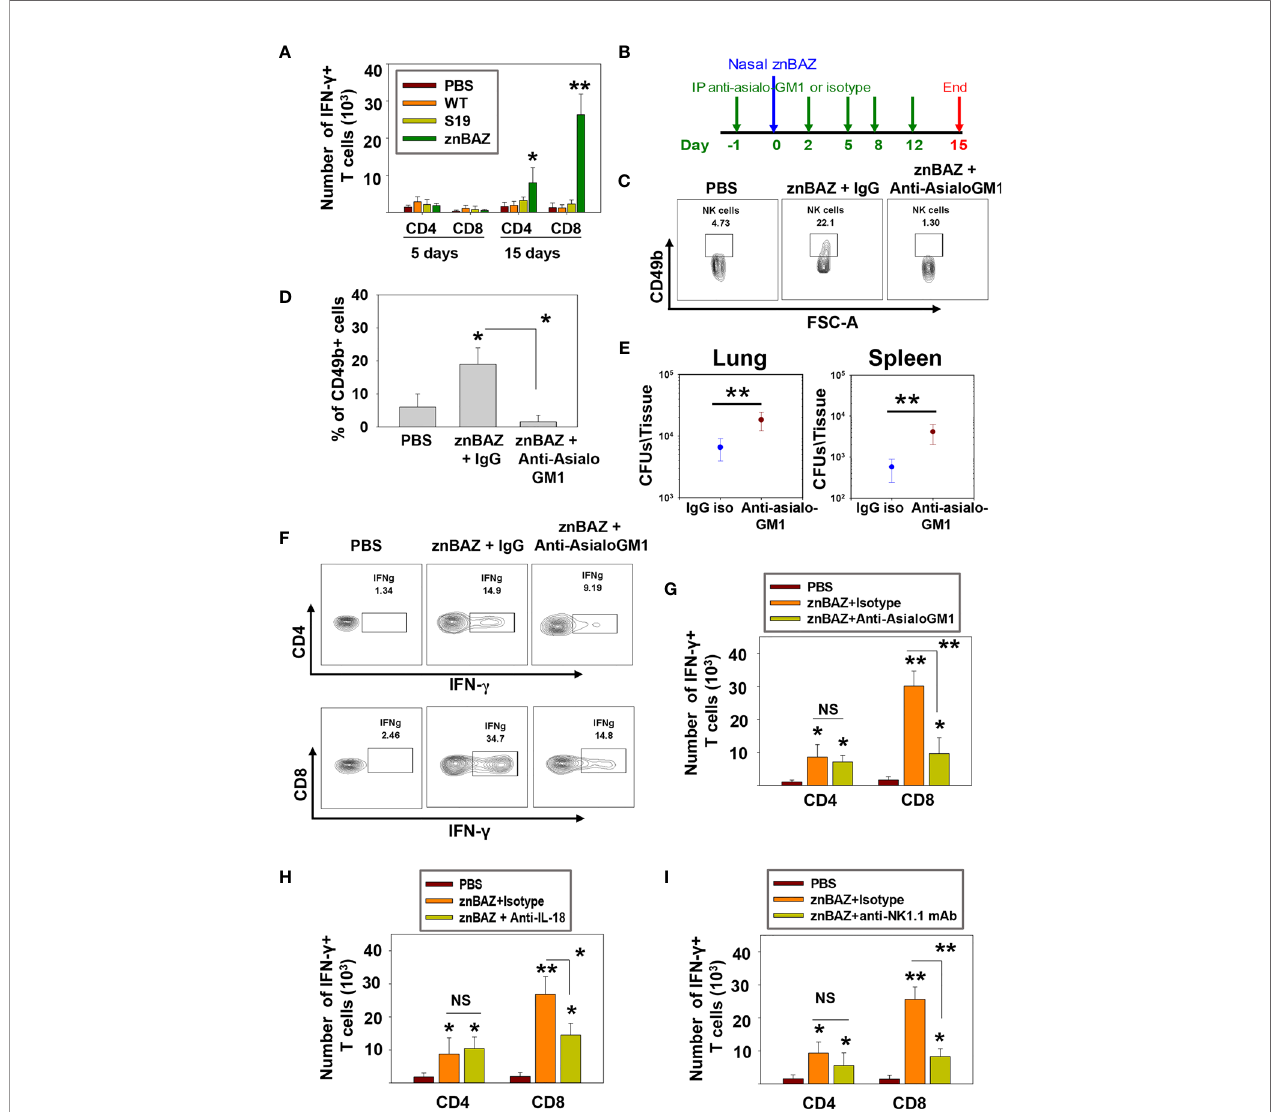
FIGURE 6 | znBAZ induces an early NK cell response that augments CD8 + T cell response in the lungs. (A) Lung lymphocytes were analyzed on days 5 and 15 post-infection for IFN- g -producing CD4 + and CD8 + T cells from BALB/c mice nasally infected with wt B. abortus (1×10 5 CFUs), S19 (1×10 8 CFUs), or znBAZ (1×10 9 CFUs). (B) Groups of BALB/c mice were nasally infected with znBAZ (1×10 9 CFUs) or sPBS on day 0. One half of znBAZ-dosed mice was depleted of NK cells with rabbit anti-asialo-GM1 Ab, and the other half was treated with an equivalent amount of normal rabbit IgG on days -1, 2, 5, 8, and 12. (B, C) NK cell depletion in the lungs was veri fi ed on days 5 and (D) 15 post-infection. On day 15 post-infection, (E) lungs and spleen from mice dosed with znBAZ + IgG or znBAZ + anti-asialo- GM1 Ab were evaluated for extent of znBAZ colonization, and (F, G) for the number of IFN- g -producing CD4 + and CD8 + T cells. (H) Separate groups of BALB/c mice were nasally dosed with znBAZ (1×10 9 CFUs) or sPBS on day 0. One half of znBAZ-dosed mice were treated i.p. with an anti-IL-18 mAb and the other half with an equivalent amount IgG isotype control on days -1, 2, 5, 8, and 12. Analysis of lung lymphocytes for IFN- g -producing CD4 + and CD8 + T cells was performed on day15 post-infection. (I) Groups of B6 mice were treated with anti-NK1.1 mAb to deplete NK cells or IgG isotype control Ab, and dosed with znBAZ as described in (B) . sPBS was administered to one group as negative control. Analysis of lung IFN- g -producing CD4 + and CD8 + T cells in control and NK cell-depleted B6 mice is shown at 15 days post-infection. The data depict the means ± SEM of 10 mice/group (two experiments combined); *p < 0.01 and **p ≤ 0.001, compared with sPBS-dosed mice or as indicated; NS is not signi fi